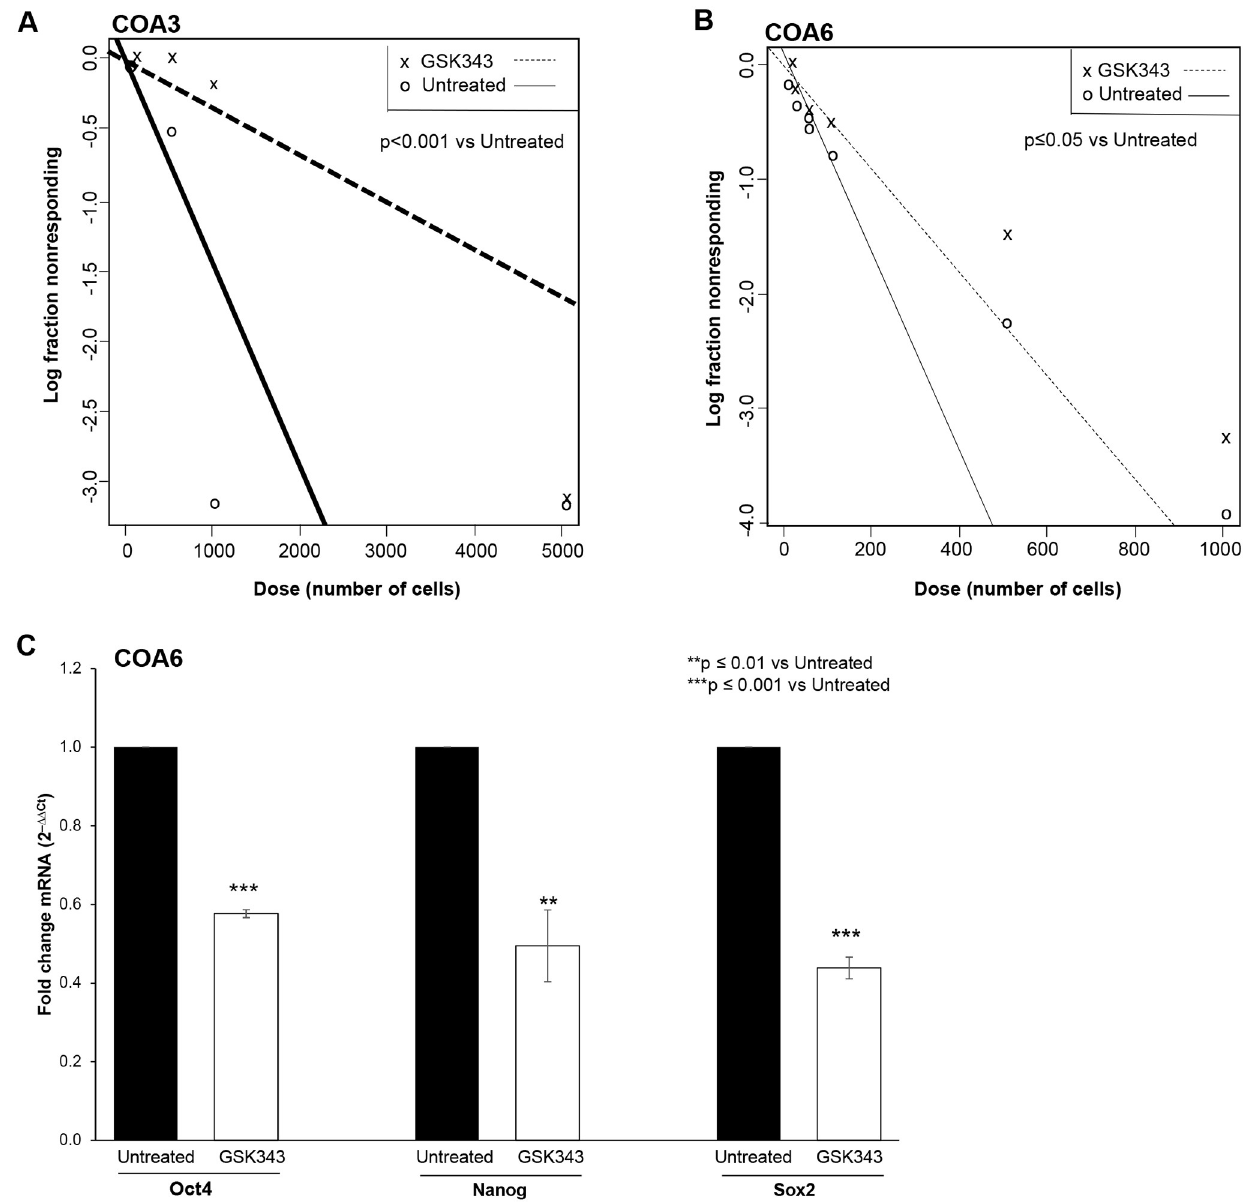
Fig 5. GSK343 decreased tumor stemness. (A) COA3 and (B) COA6 PDX cells were plated as single cell suspension in serum-free, conditioned media onto 96-well low attachment plates using serial dilutions with 5000, 1000, 100, 50, 20, 10, and 1 cell per well. Cells were treated with GSK343 (0, 5 μ M). After one week, the number of wells containing tumorspheres in each row was counted by a single researcher and the results were analyzed using the extreme limiting dilution analysis software (http://bioinf.wehi.edu.au/software/elda/). Treatment with GSK343 significantly decreased tumorsphere formation by both the COA3 (A) and COA6 (B) cells, representing a decrease in stem cell-like phenotype. (C) COA6 cells were treated with GSK343 (0, 5 μ M) for 72 hours. qPCR demonstrated a significant decrease in mRNA abundance of known stemness markers Oct4, Nanog, and Sox2 following GSK343 treatment compared to untreated cells. Data presented represent results from at least three biologic